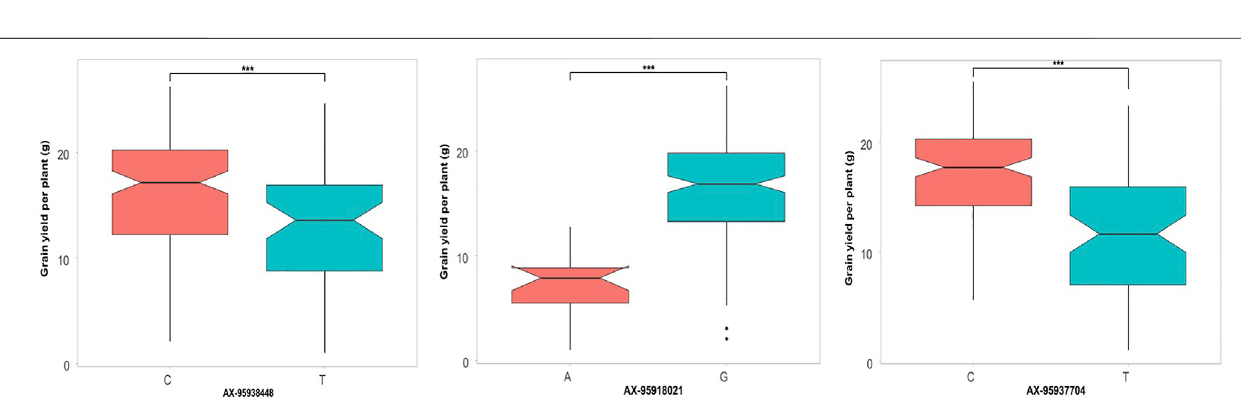
FIGURE 7 | Comparison of allelic effects of major QTNs identi fi ed in the present study for grain yield per plant under reproductive stage heat stress.